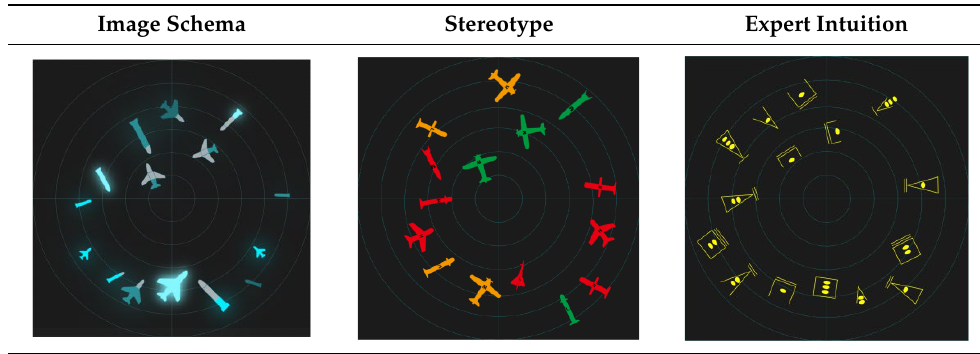
Table 5. Types of experimental interfaces.